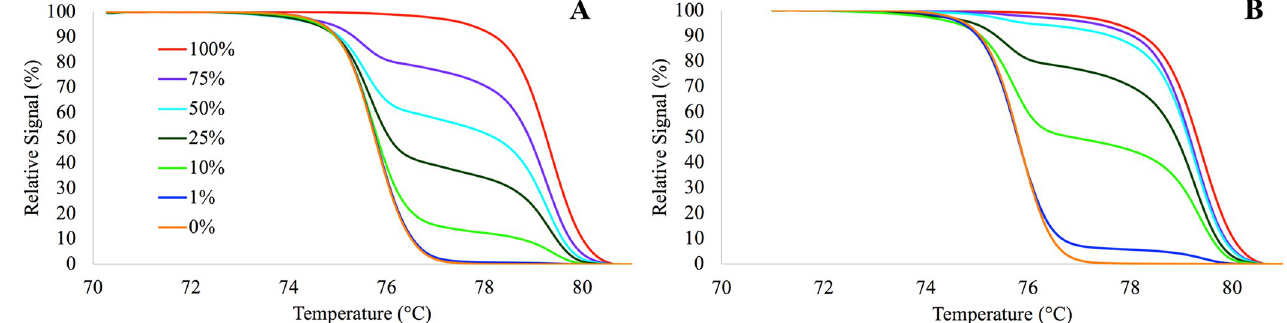
Fig 7. Example of HRM curves for the MS-HRM designed according to Wojdacz et al., and performed at low and high PCR annealing temperature. (A) low temperature, HRM curves representing 75%, 50%, 25% and 10% methylation levels are clearly distinguishable. (B) at high temperature only HRM curves representing 25%, 10% but at the same time the HRM curve representing 1% methylation level is now visible. The sensitivity of the assay is increased with the increased PCR annealing temperature but the dynamic range of the assay decreases.